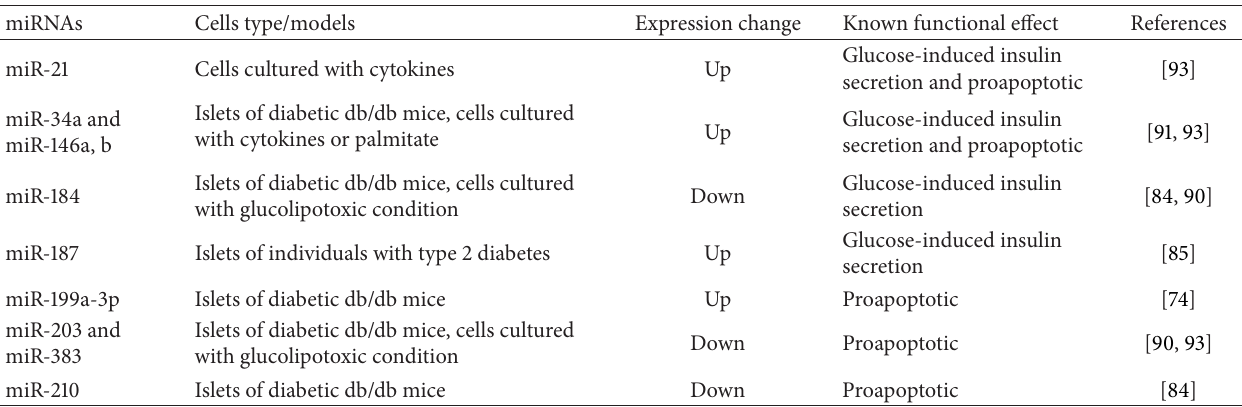
Table 4: miRNAs associated with beta-cell failure.